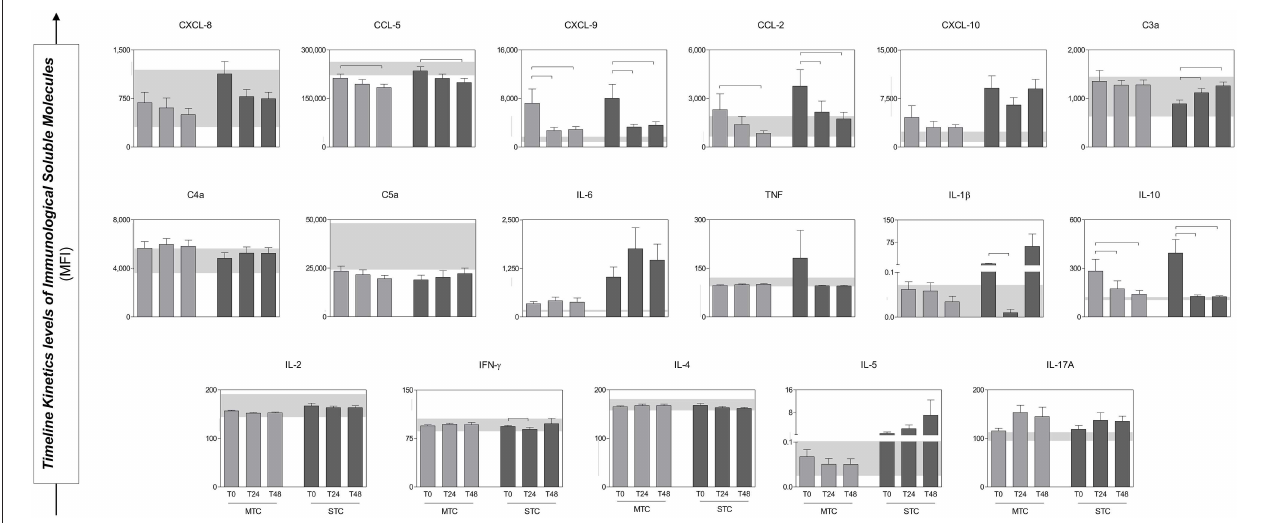
FIGURE 5 | Serum concentrations of Immunological Soluble Molecules of patients (MTC and STC) during the follow up. At the bottom, the interquartile range (25–75) of the serum concentrations in the HD group is shown as the baseline parameter. Statistical difference between MTC and STC groups, p < 0.05 was considering significant (